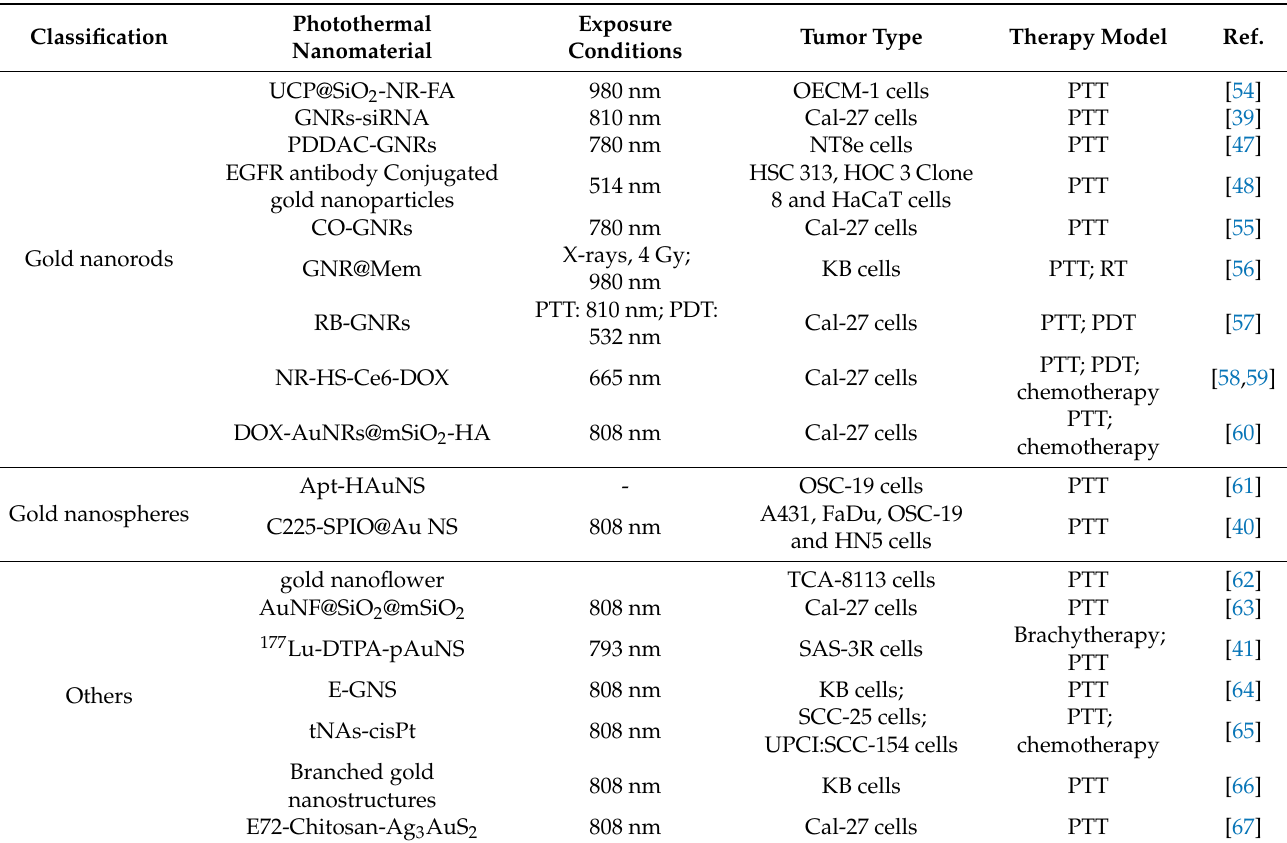
Table 1. A summary of noble metal nanomaterials for PTT in